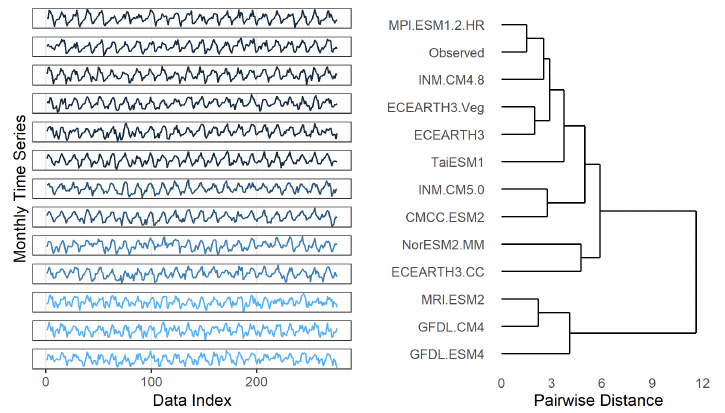
Figure 4. Clusters for the monthly maximum temperature series for the observed and climate model series (the left figure shows the cluster separation with the blue color contrast, and the right figure shows the clustering of climate models and observed data in terms of time series similarity based on the seasonal pattern).